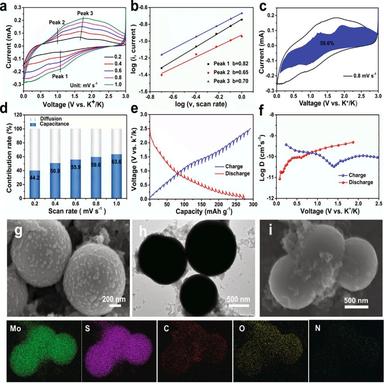
Electrochemical kinetics of 1 T-MoS2/MoOx@NC for PIBs: (a) CV curves at different scan rates ranging from 0.2 to 1 mV s − 1 , (b) relationship between log i and log ν of cathodic and anodic peaks, (c) CV curve with capacitive contribution to the charge storage at 0.8 mV s − 1 , (d) capacitive contribution rates, (e) GITT curves, (f) K-ion diffusion coefficient, (g) and (h) FESEM and TEM images of cycled 1 T-MoS2/MoOx@NC, (i) FESEM elemental mappings of Mo, S, N ,O and C.